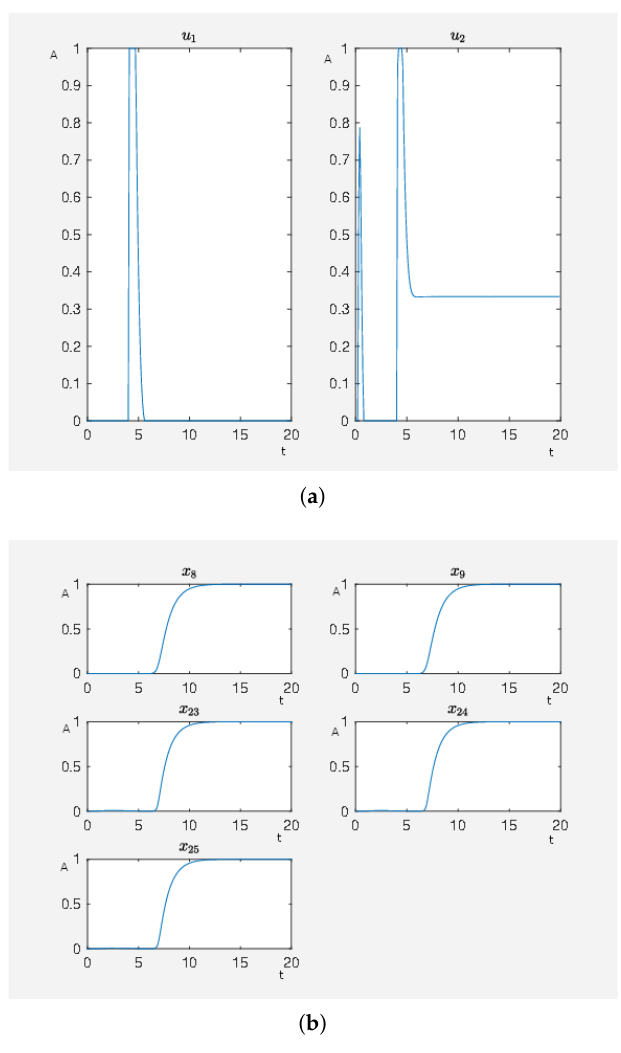
Figure 5. A hypertrophic stimulus with angiotensin II and isoproterenol. ( a ) Time curve of the external stimuli where u 1 activates angiotensin II and u 2 isoproterenol. On the abscissa, we have the time (t) and on the ordinate the activity level (A). ( b ) Time curve of the nodes of interests where x 8 is the activity level of p90RSK, x 9 is the activity level of p70S6K, x 23 is the activity level of Elk1, x 24 is the activity level of MSK1 and x 25 is the activity level of c-Myc. On the abscissa, we have the time (t) and on the ordinate the activity level